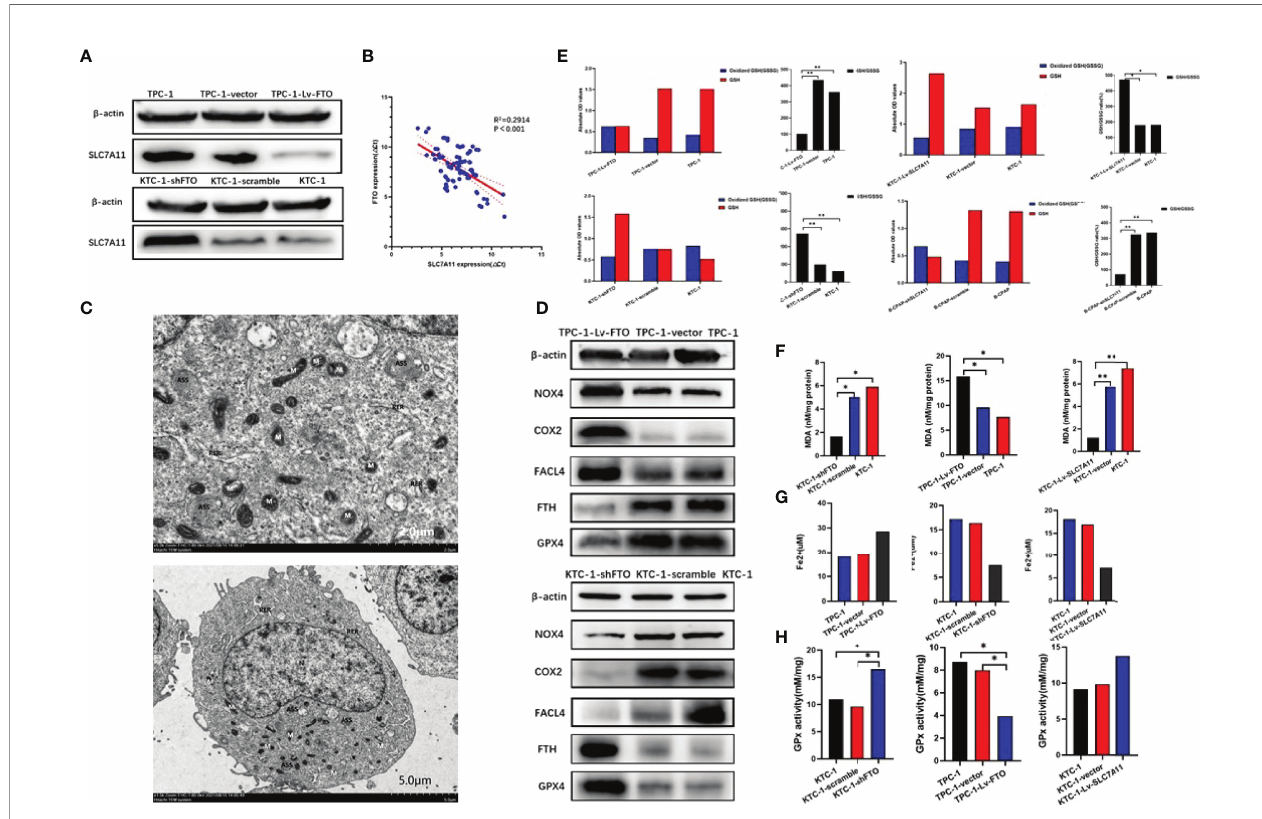
FIGURE 7 | Ferroptosis plays an important role in papillary thyroid carcinoma. Fat mass and obesity-associated protein (FTO) regulates papillary thyroid carcinoma (PTC) cell ferroptosis by mediating the m6A methylation of SLC7A11. (A) SLC7A11 protein expression was examined by western blot in TPC-1-Lv-FTO, TPC-1- vector, TPC-1, KTC-1-shFTO, KTC-1-scramble, and KTC-1 cell. (B) The mRNA expression of FTO and SLC7A11 in PTC tissue specimens was analyzed by Spearman rank correlation coef fi cient. (C) Ultrastructure of the mitochondria in TPC-1-Lv-FTO cells as imaged by TEM. Red arrowheads, shrunken mitochondria. Scale bars, 2.0 and 5.0 m m. The cells were ovoid, the cell membrane was intact and continuous, a few pseudopods were visible around, the cytoplasm was not obviously edematous, the nucleus was regular, roughly ovoid, and the chromatin was evenly distributed. The mitochondria were fi xed, the matrix density was increased, and the cristae were obviously dilated, showing signs of ferroptosis. The rough endoplasmic reticulum was mildly dilated and locally degranulated. A few autophagic lysosomes were visible intracellularly. (D) NOX4, COX2, ACSL4, GPX4, and FTH as ferroptosis biomarkers were measured in control and TPC-1-Lv-FTO/ KTC-1-shFTO cells by western blot. (E) The glutathione (GSH)/oxidized GSH ratio was measured in the indicated PTC cells; * P < 0.05, ** P < 0.001. (F) Malondialdehyde (MDA) analysis for the evaluation of levels of oxidative stress. MDA was measured in the indicated PTC cells; * P < 0.05, ** P < 0.001. (G) Fe 2+ was measured in the indicated PTC cells; * P < 0.05, ** P < 0.001. (H) GPx was measured in the indicated PTC cells; * P < 0.05, ** P <